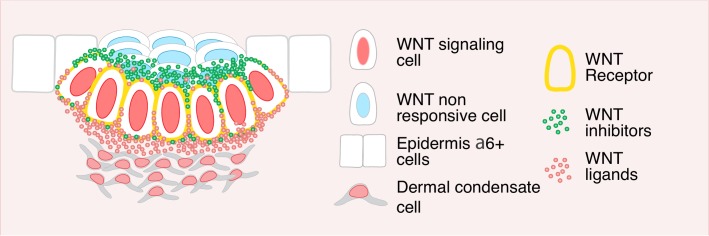
Summarizing model.WNT signaling basal progenitors form opposing intracellular morphogen gradients of WNT inhibitors and WNT ligands/activators. In so doing, they preserve their own WNT signaling and identity and directionally permit (dermal condensate) or restrict (suprabasal hair bud cells) WNT signaling in surrounding neighbors.